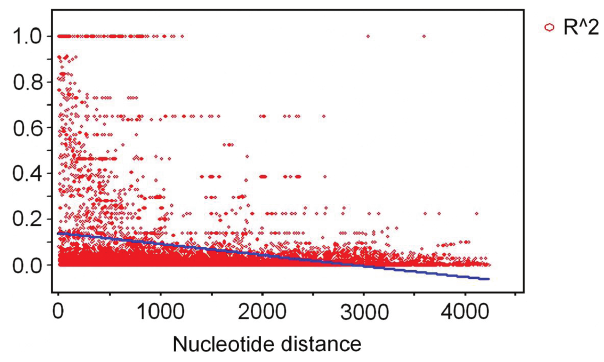
Figure 4. Decay of linkage disequilibrium within PtUXS1 gene. Pairwise correlations between SNPs are plotted against the physical distance between the SNPs in base pairs. The straight line describes the least squares fit of r 2 (Er2) to its expectation. Linkage disequilibrium has largely decayed within 700 bp.